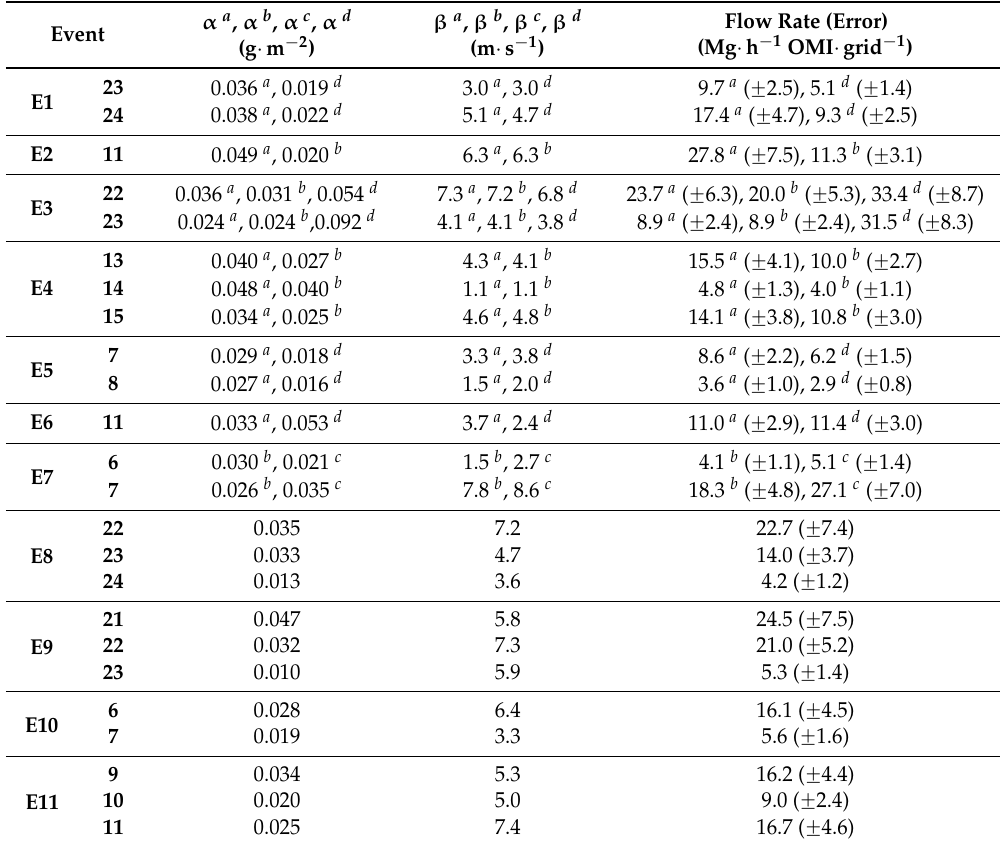
Table 2. Estimated LRT-SO 2 flow rate and the parameters ( α and β ) used to estimate the long-range transported flow rate for each